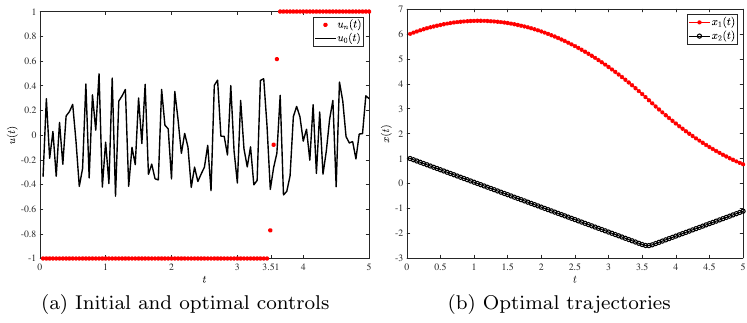
Figure 4. Numerical results for Example